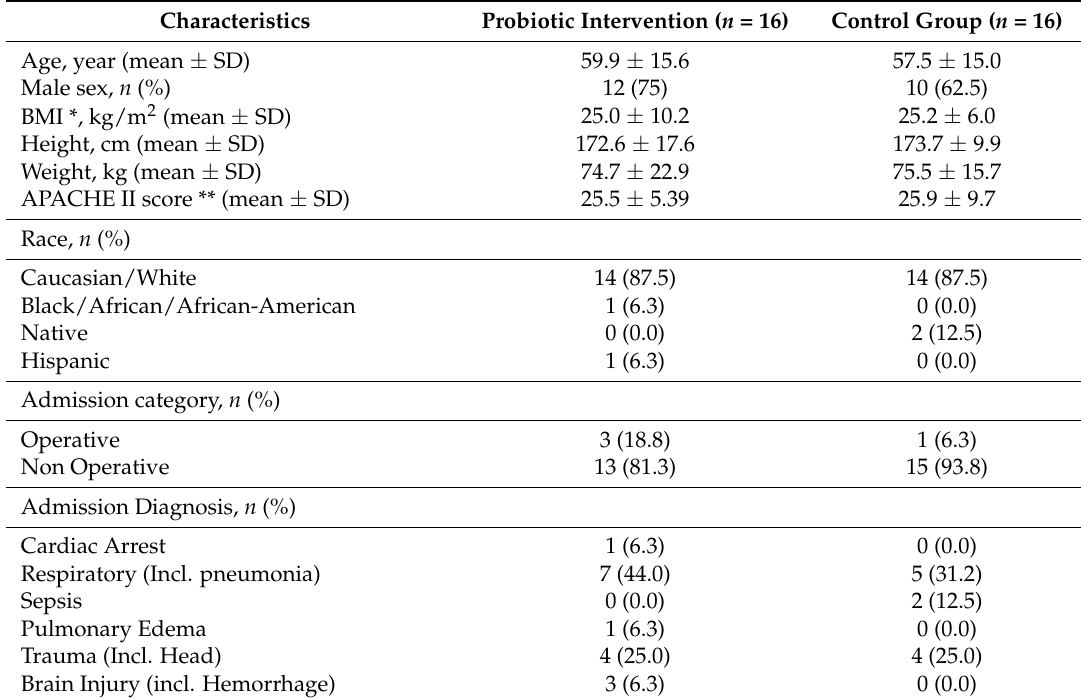
Table 1. Baseline Characteristics of critically ill